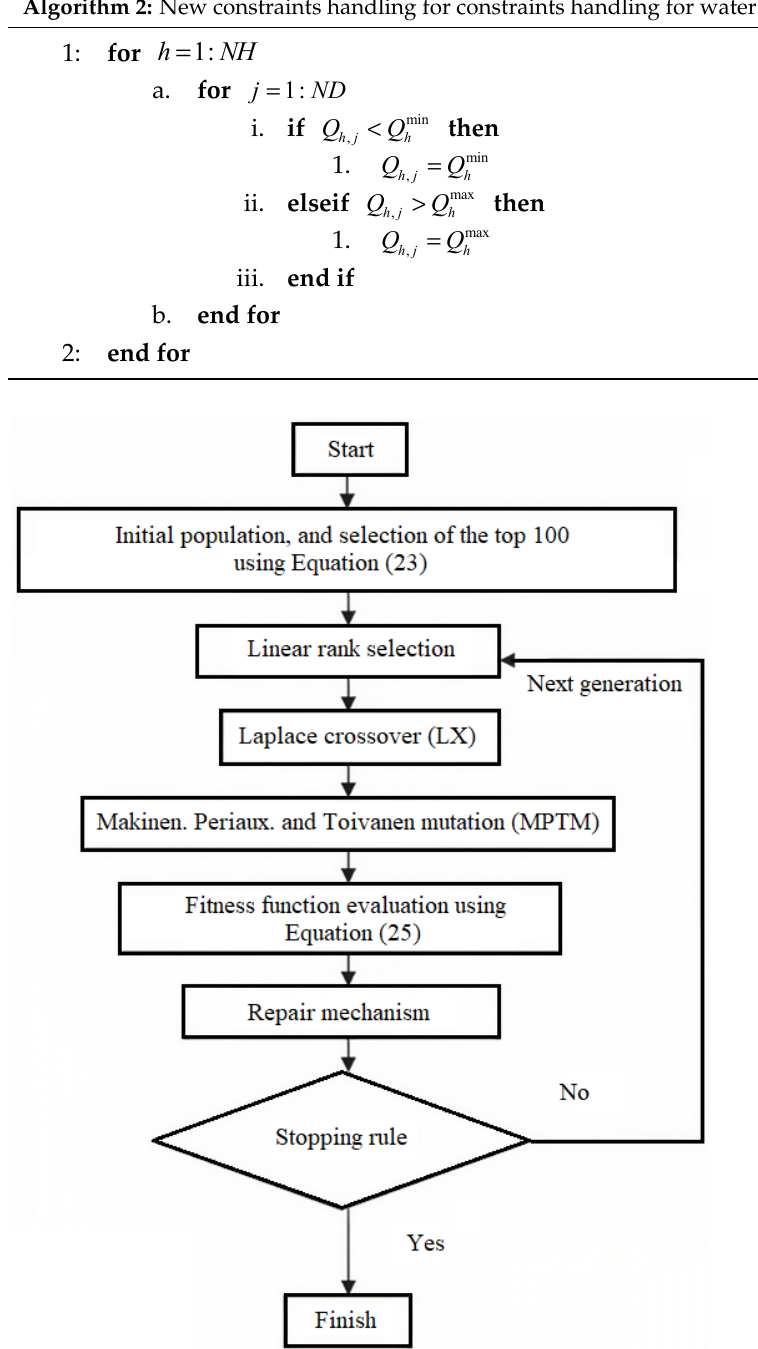
Figure 3. Simplified flowchart of the proposed SAGA.